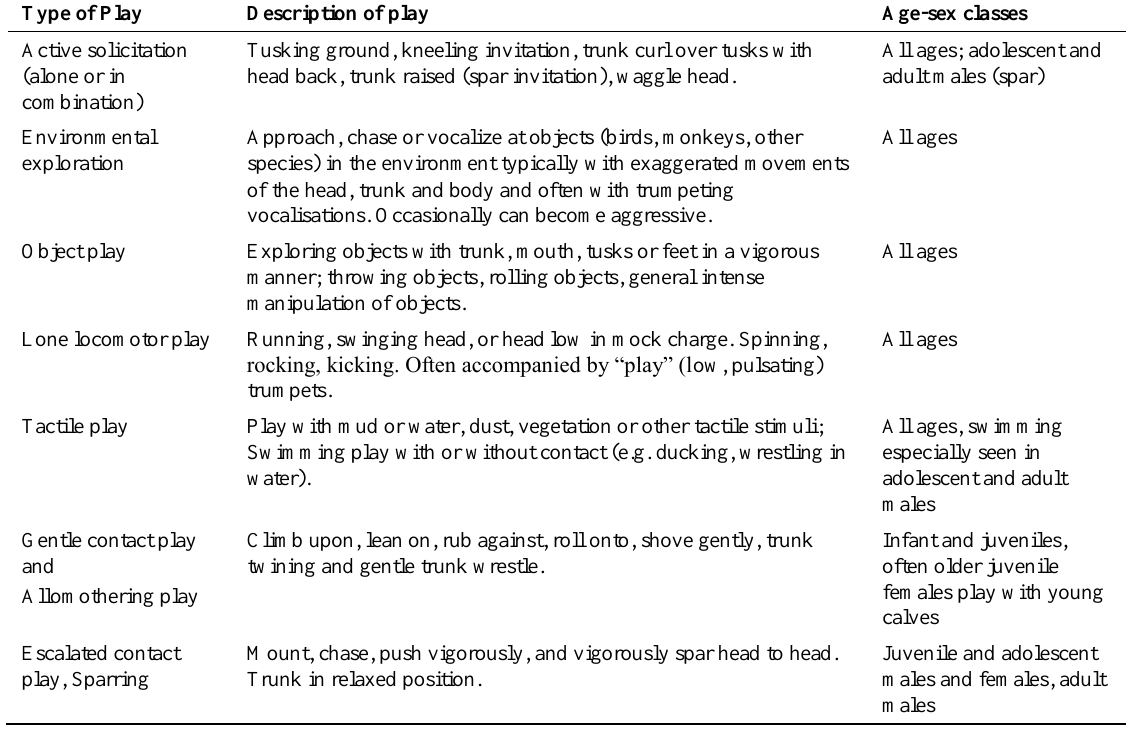
Types of Play and the Age-Sex Classes that Engage in this Play Most